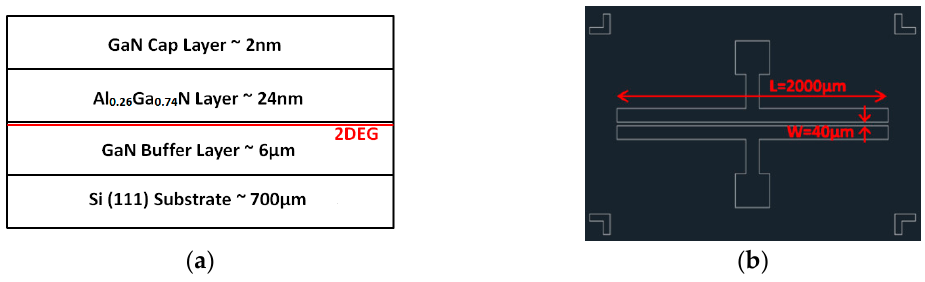
Figure 1. ( a ) Epitaxial structure of the AlGaN / GaN-based two-dimensional electron gas (2DEG) wafer; ( b ) mask design of the optimized metal-semiconductor-metal (MSM) varactor.